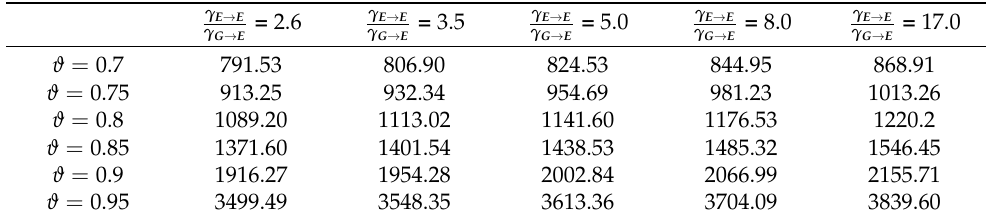
Table A4. Impact of the initial system status and the ϑ discount parameter on the discounted profit resulted by the optimized maintenance policy.